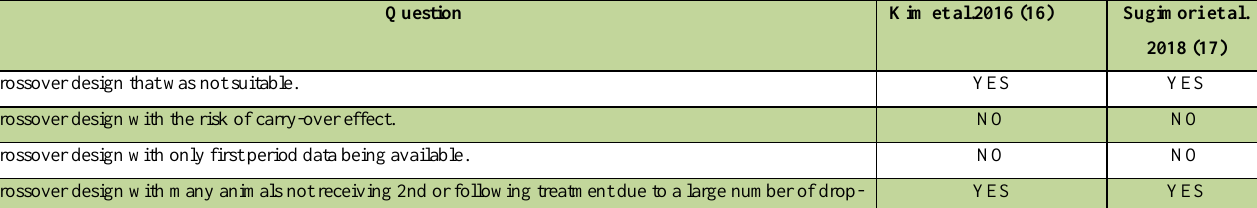
Table 5. Risk of bias assessment according to SYRCLE’s RoB